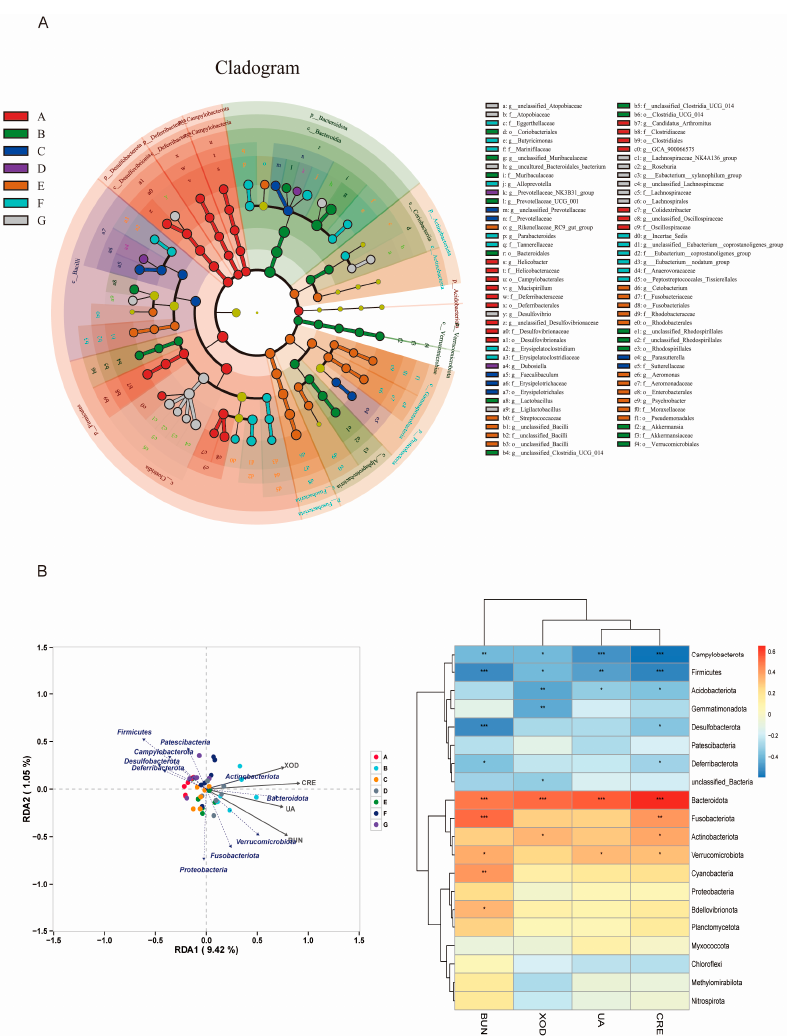
Figure 9. Effects of fermented dandelion on intestinal microbiota of mice with HUA. ( A ) LEfSe analysis; ( B ) Relativity analysis. The data are expressed as mean ± SD (n = 6). Compared with HUA index, * p < 0.05, ** p < 0.01, *** p < 0.001. A: Control; B: Model; C: ALL, allopurinol; D: D − L, dandelion low dose group; E: D − H, dandelion high dose group; F: FD − L, low dose group of LAFD; G: FD − H, high dose group of